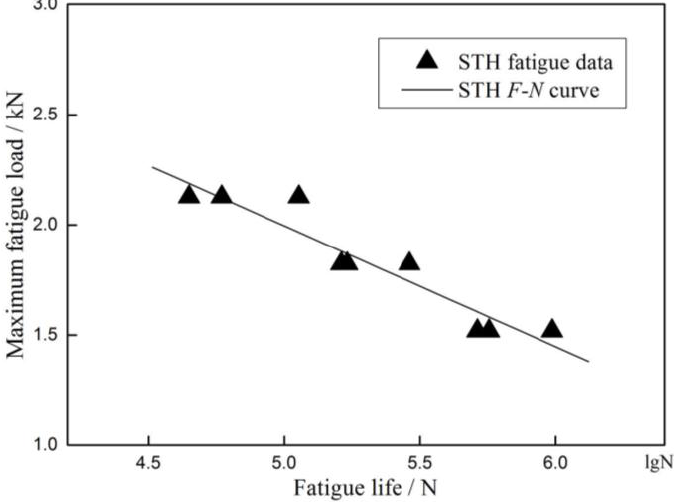
Figure 7. F - N curve of the STH joints.